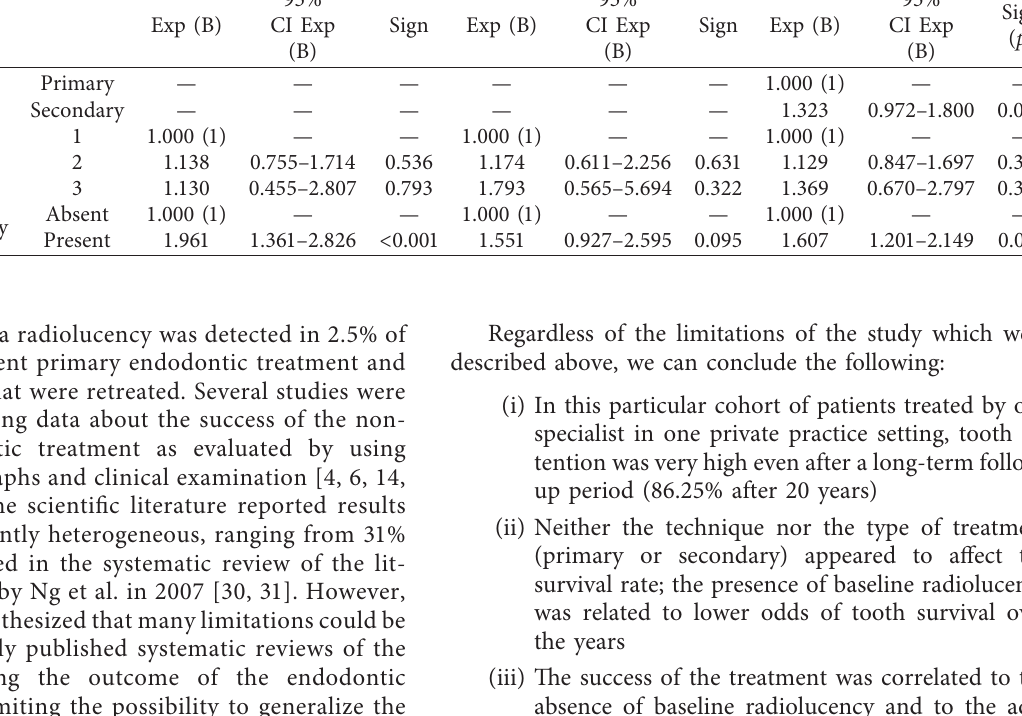
Table 3: Influence of baseline parameters on teeth survival. Primary treatment Secondary treatment